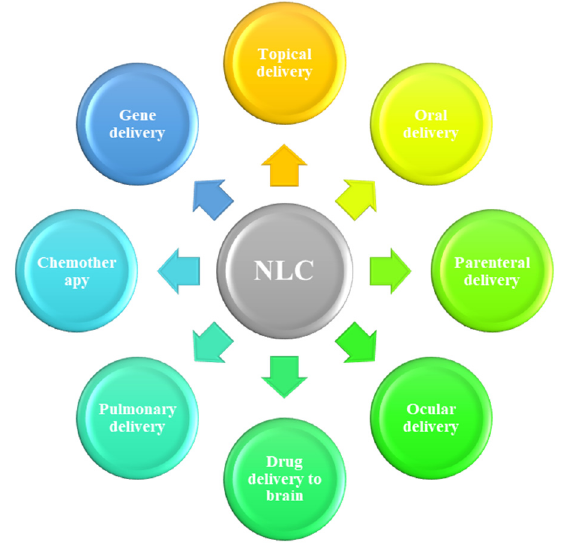
Figure 2. Applications of NLC’s as drug delivery systems.